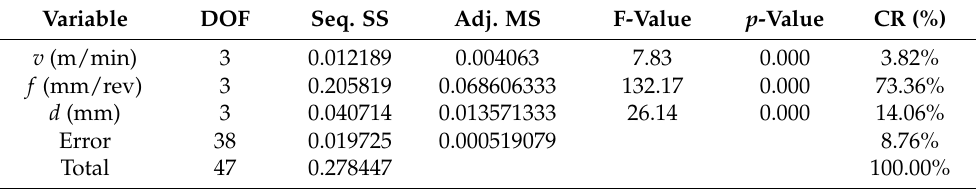
Table 9. Analysis of variance and percentage contribution results for